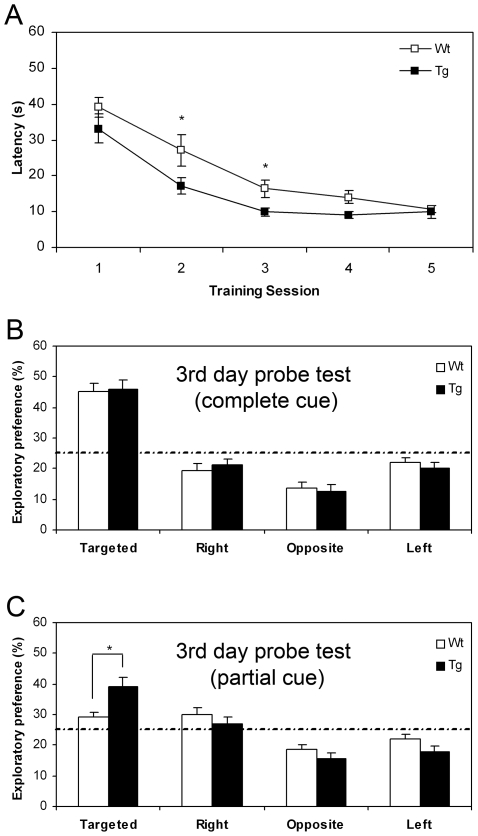
Enhanced Performance in the Hidden-platform Water Maze Task by NR2B Transgenic Rats.A: Escape latency in water maze training. Transgenic rats spent the significant less time to find the platform during the second and third training sessions. B: At the end of the third training session, spatial memory function was tested under full cue condition. Transgenic and Wt rats exhibited equal amount of strong preference for the target quadrant under full-cue conditions (Student's t-test, *P<0.05). C: Place preference was further tested at the end of the third training session under the partial cue condition. Transgenic rats spent more time in the target quadrant than other quadrants, in comparison to that of wild-type rats.